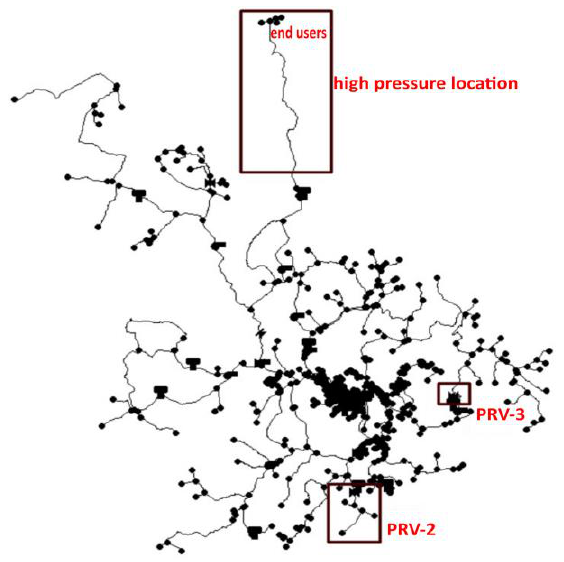
Figure 6. Network schematic with points for hydro-turbine installation. Table 1. Network characteristics.